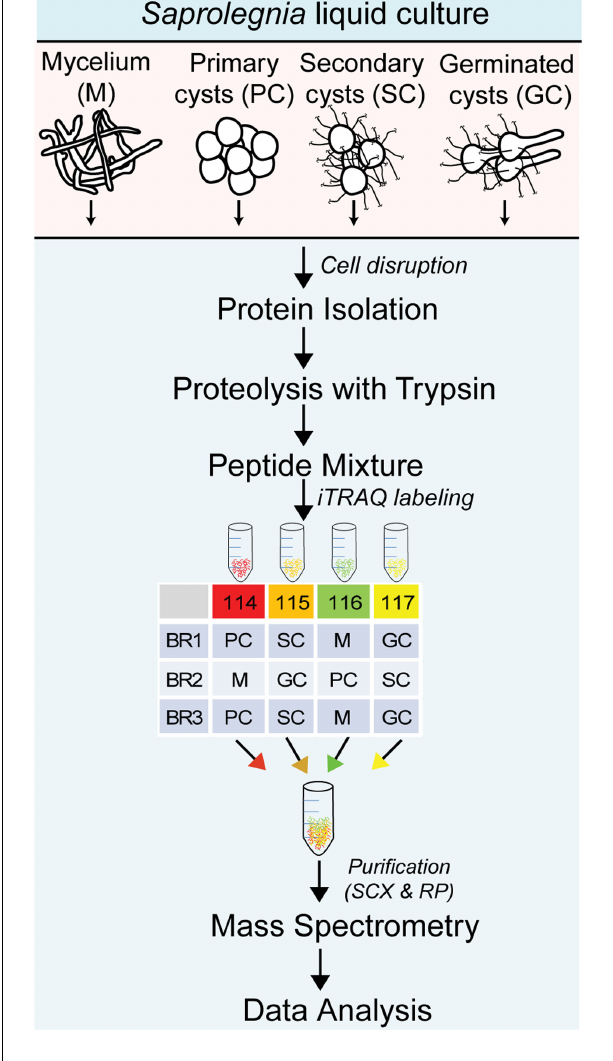
FIGURE 1 | Experimental workflow used for the quantitative proteomic analysis of different life cycle stages of Saprolegnia parasitica. M, mycelium; PC, primary cysts; SC, secondary cysts; GC, germinated cysts; iTRAQ, isobaric tags for relative and absolute quantitation; BR1, biological replicate 1; BR2, biological replicate 2; BR3, biological replicate 3; SCX, strong cation-exchange chromatography; RP, reversed-phase